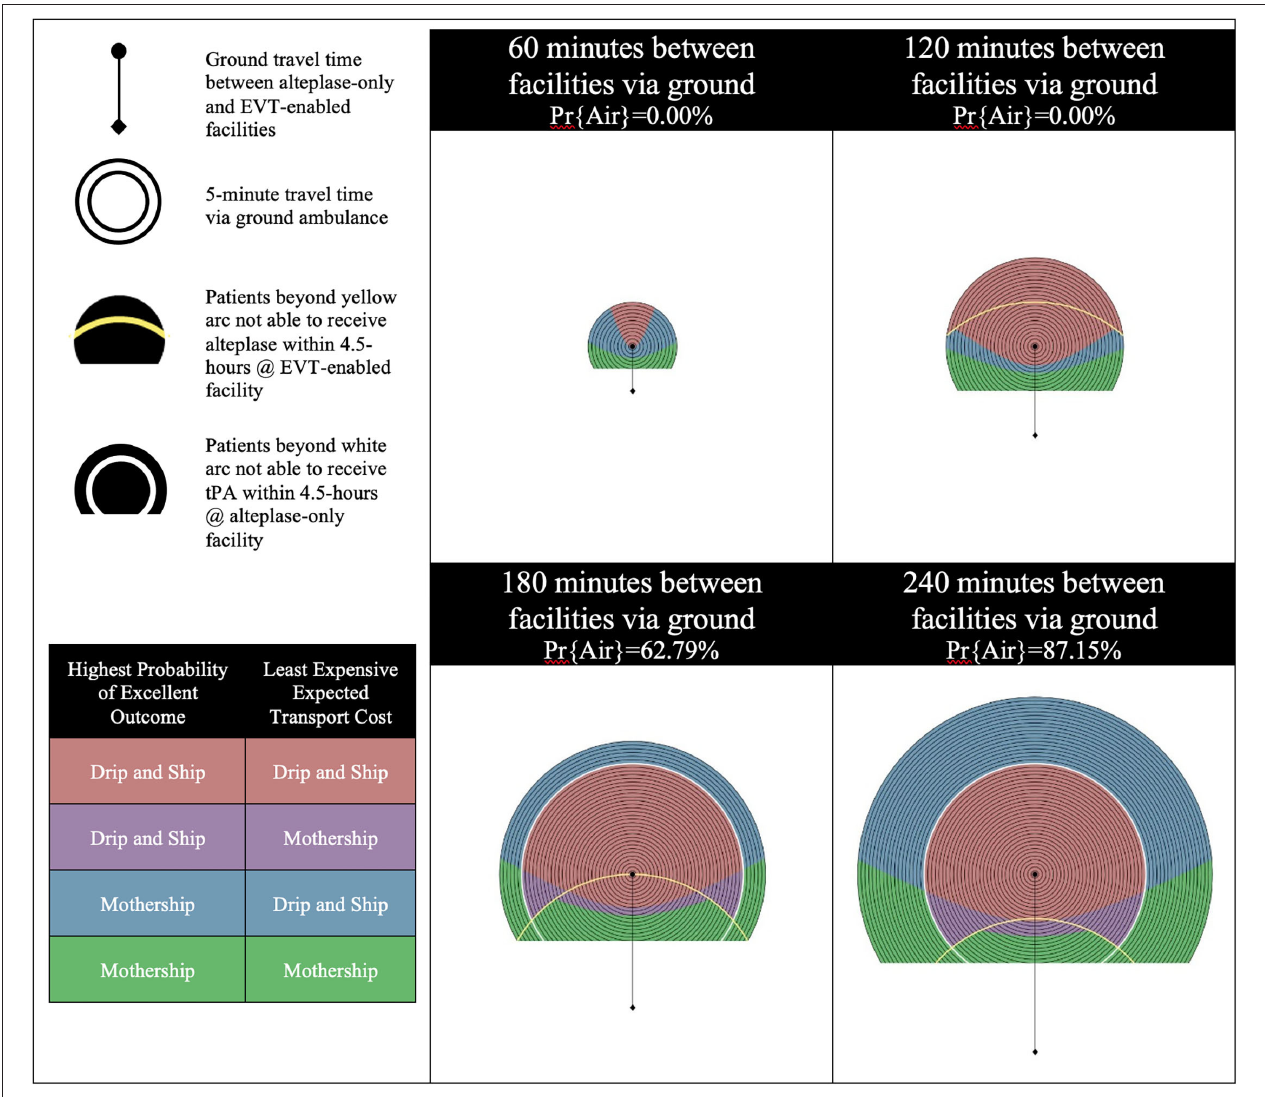
FIGURE 2 | Scenario B—Inefficient alteplase-only facility and 70% EVT eligibility for LVO patients. LVO, Large Vessel Occlusion; Pr{Air}, Probability of air transport.